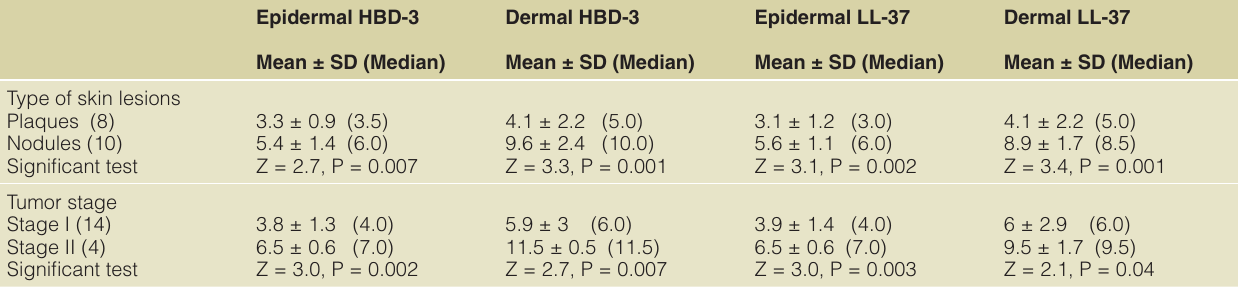
Table 2. Immunostain of HBD-3 and LL-37 regarding type of skin lesions and tumor